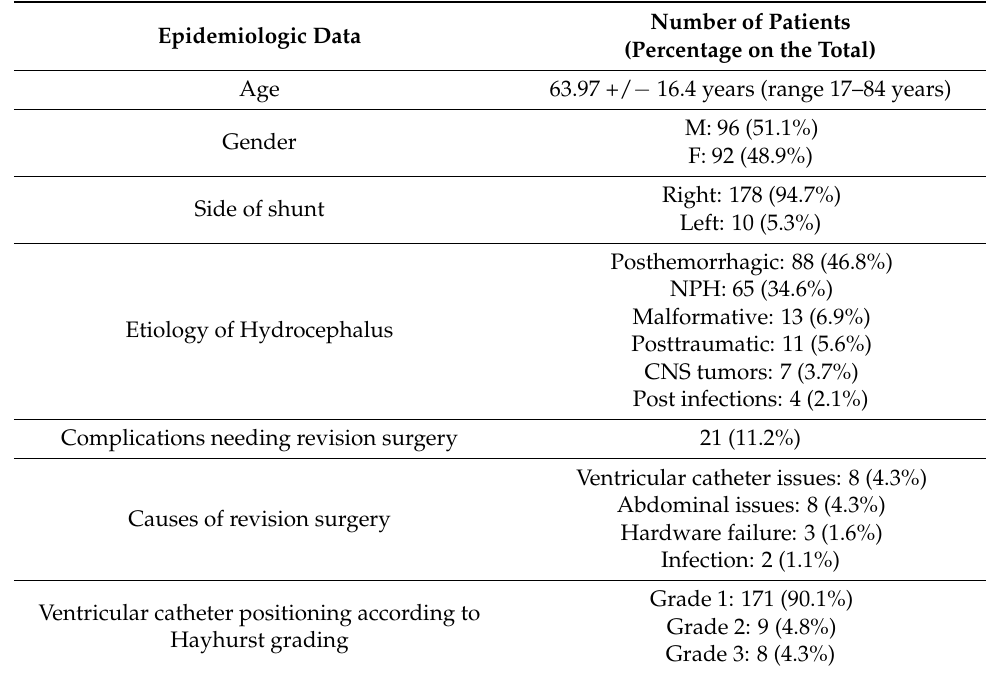
Table 1. Summaries of epidemiologic data and